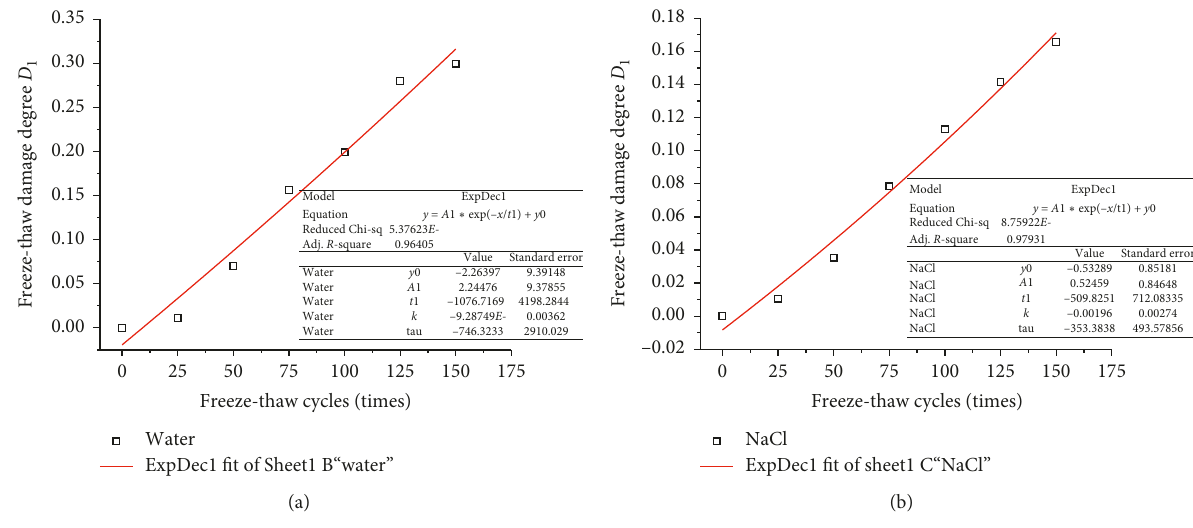
Figure 12: Fitting curve of freeze-thaw damage D